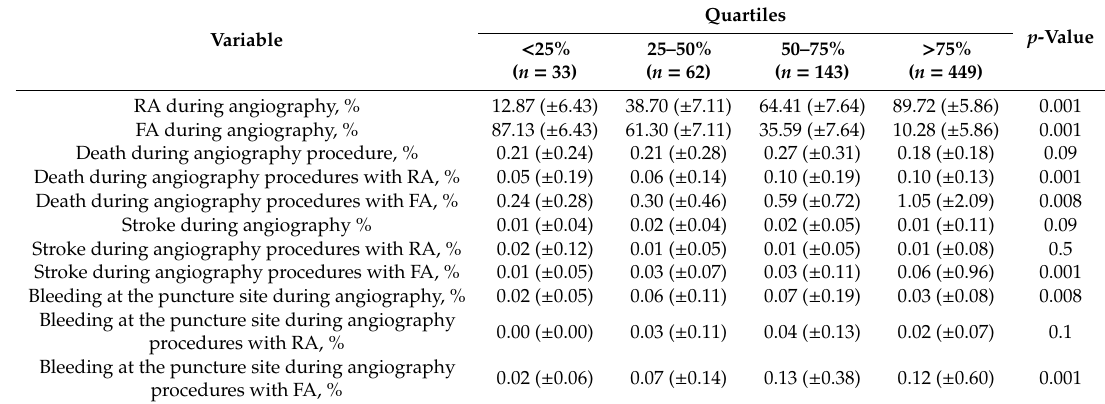
Table 3. Clinical outcomes of angiography procedure performed by operators divided into quartiles depending on operator’s utilization of radial access